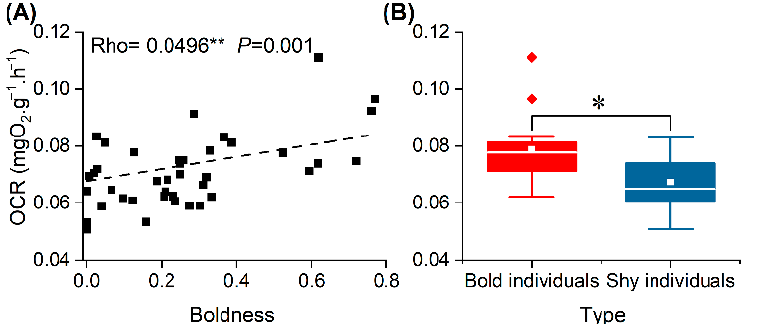
Figure 4. Correlation analysis of OCR and boldness ( A ) and difference in OCR between bold and shy individuals ( B ). Note: The white line represents the median boldness within the group, and the white rectangle represents the mean boldness within the group. Asterisk represents significant differences between groups (“*”: p < 0.05; “**”: p < 0.01). The diamonds represent outliers in the data.